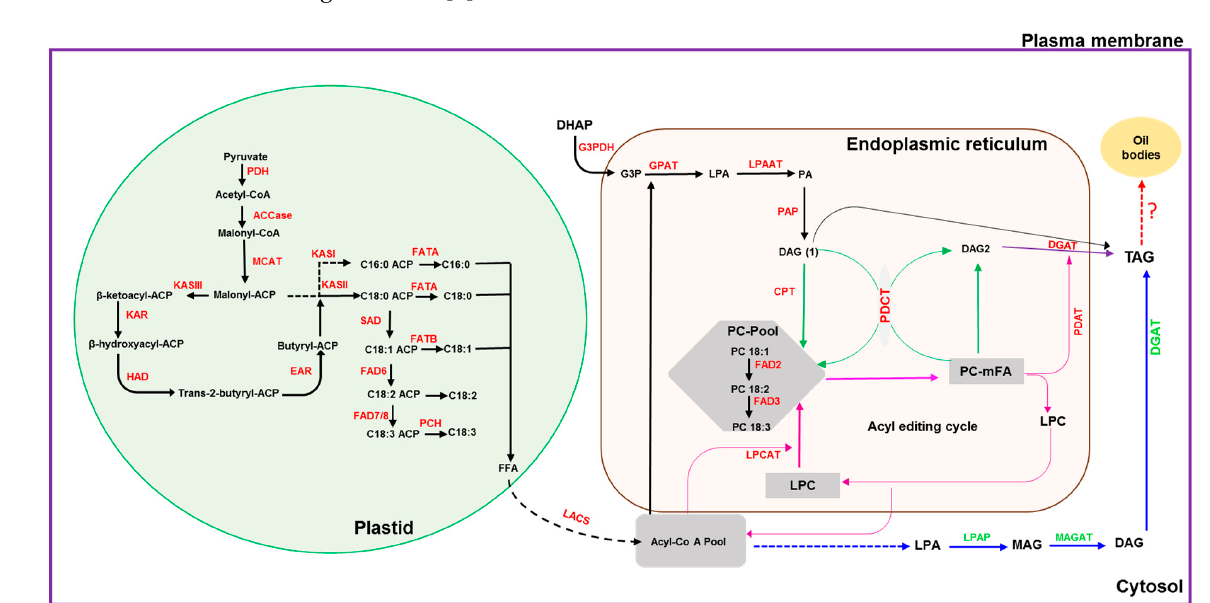
Figure 1. Schematic diagram depicting the oil biosynthesis pathway in plants (adapted from: [5–10]). The black dotted arrow indicates multiple steps in the conversion of FFA to acyl-CoA and transport; the blue dotted arrow indicates steps involved in the conversion of acyl-CoA to LPA; the red dotted arrow indicates conversion of TAG to oil bodies or lipid droplets. ACCase: acetyl-CoA